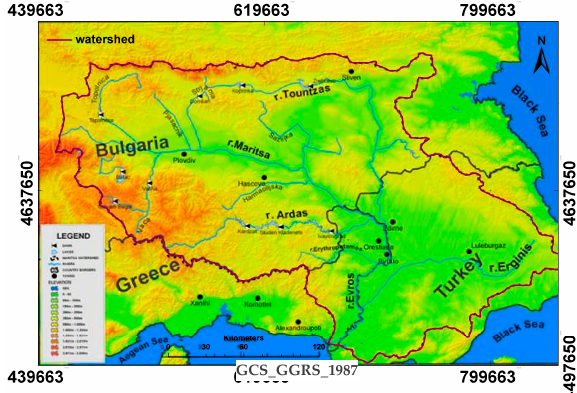
Figure 3. Transboundary Evros river and its tributaries. The examined data are derived from Pythio’s bridge (41°21 ′ 43.51 ″ N 26°37 ′ 51.67 ″ E) (from Angelidis et al.,